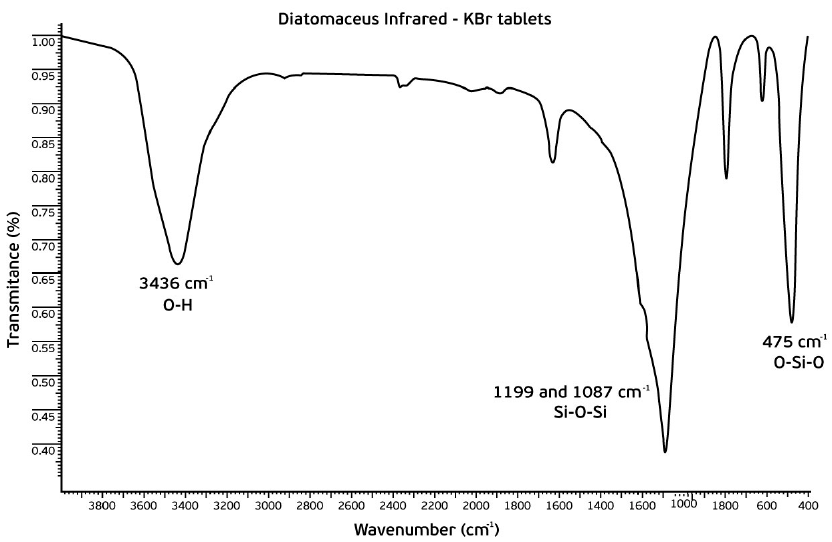
Figure 2. FTIR spectrum of the biosorbent, previously conditioned at 240 °C.